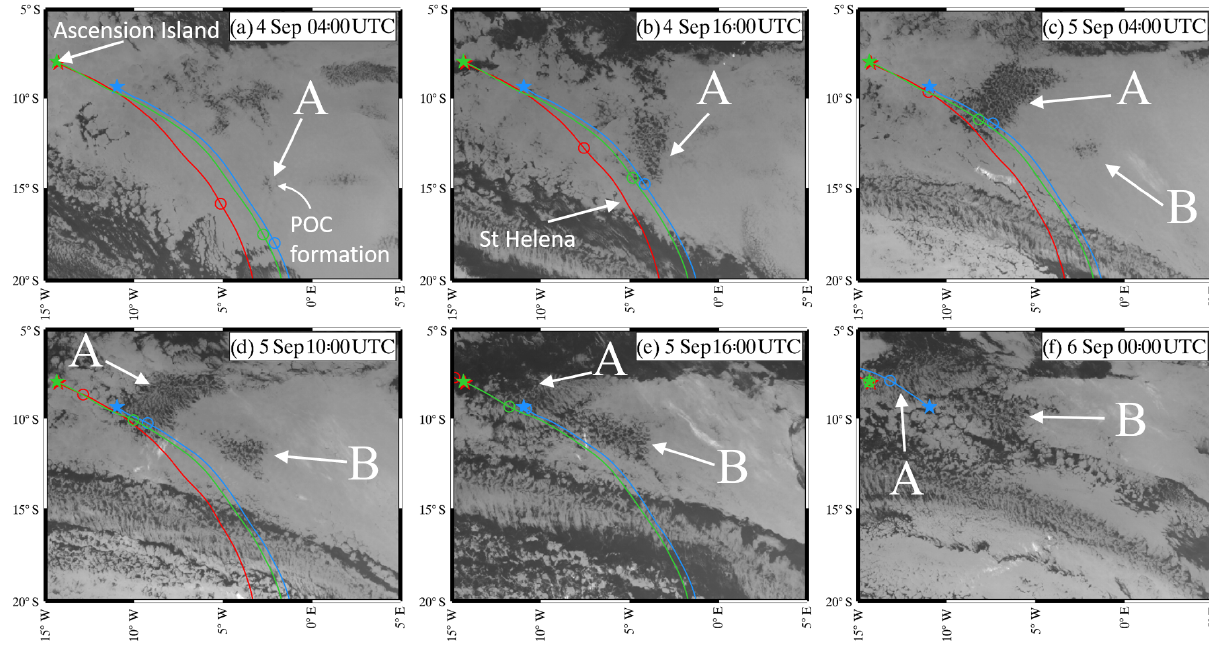
Figure 2. The 10.8µm brightness temperature imagery from SEVIRI showing the evolution of the POC feature as a function of time from 4 to 6 September 2017. The main POC (labelled A) and a secondary POC feature (labelled B) are indicated. Three trajectories are overlaid on the imagery. These are initialised at 500m altitude from the position and time of measurements made (i) from the aircraft in the stratiform cloud region downwind of the POC (P0, red), (ii) from the aircraft within the POC (P6, blue) and (iii) from the LASIC site on Ascension Island within the POC (green). The stars on the trajectories show the position where each measurement was made and the open circles show the position along the trajectory at the time of each satellite image. The location of Ascension Island is shown with a green